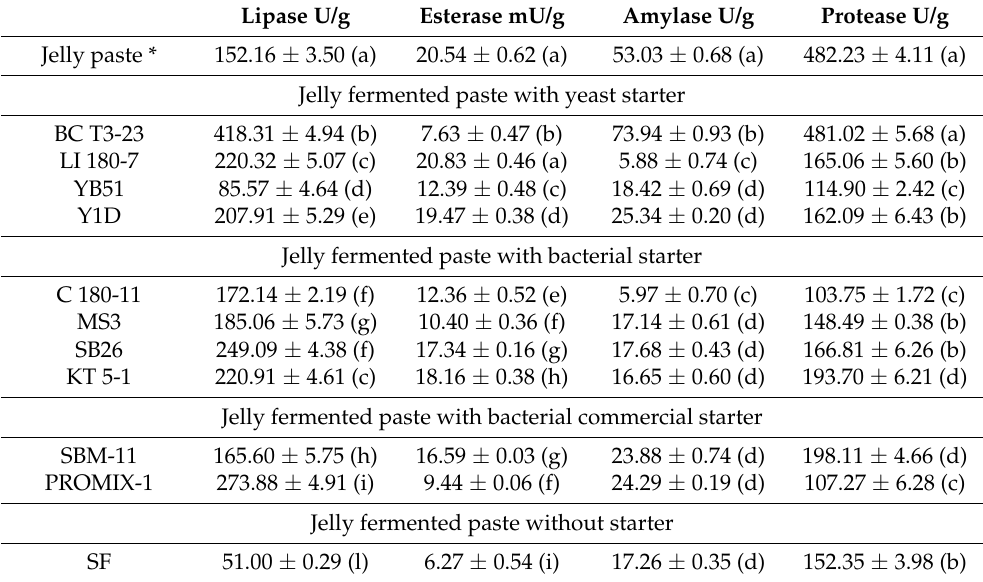
Table 6. Enzyme activities associated with fermented Jellyfish paste